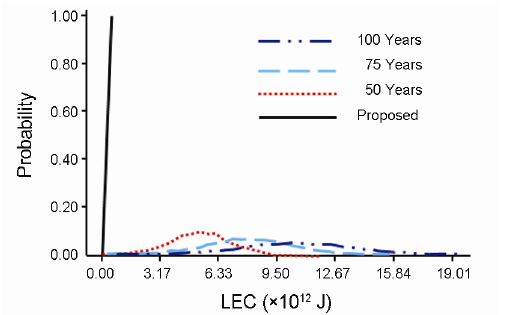
Fig. 16. Comparison of the results from different methods (Probability density function)